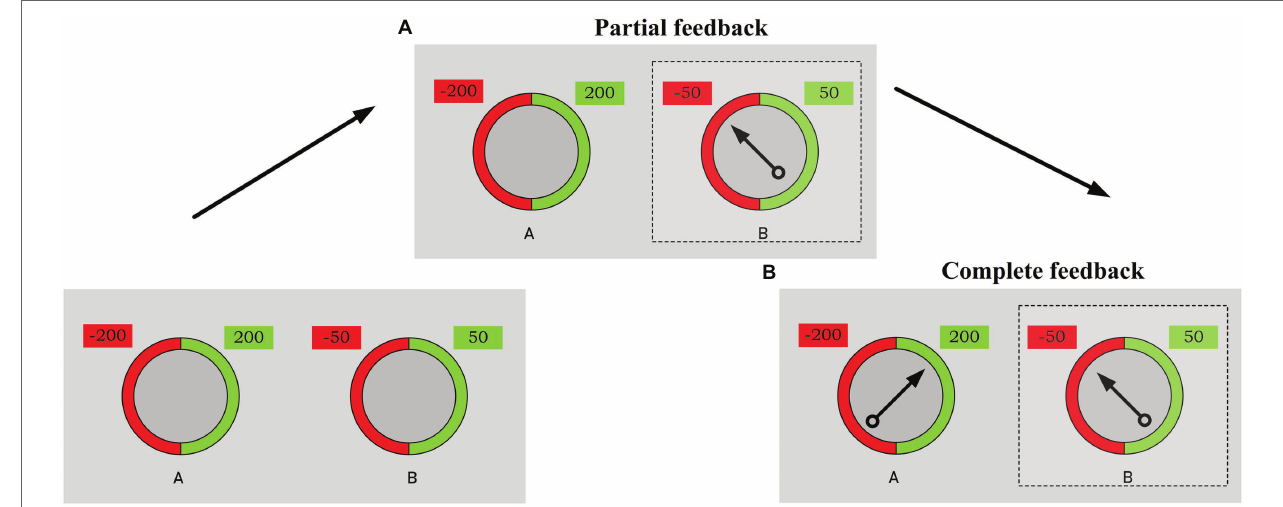
FIGURE 1 | The regret gambling task is similar to the one used by Coricelli et al. (2005). The colored areas on the two wheels represent the probabilities (50/50) associated with monetary gains (green) and losses (red). A dashed box emphasizes the selected wheel. (A) Represents a partial feedback condition, where the outcome is provided only for the chosen wheel (the stopping position of the arrow (in black) indicates the result of a loss). (B) Represents the complete feedback condition, where the results for both wheels are